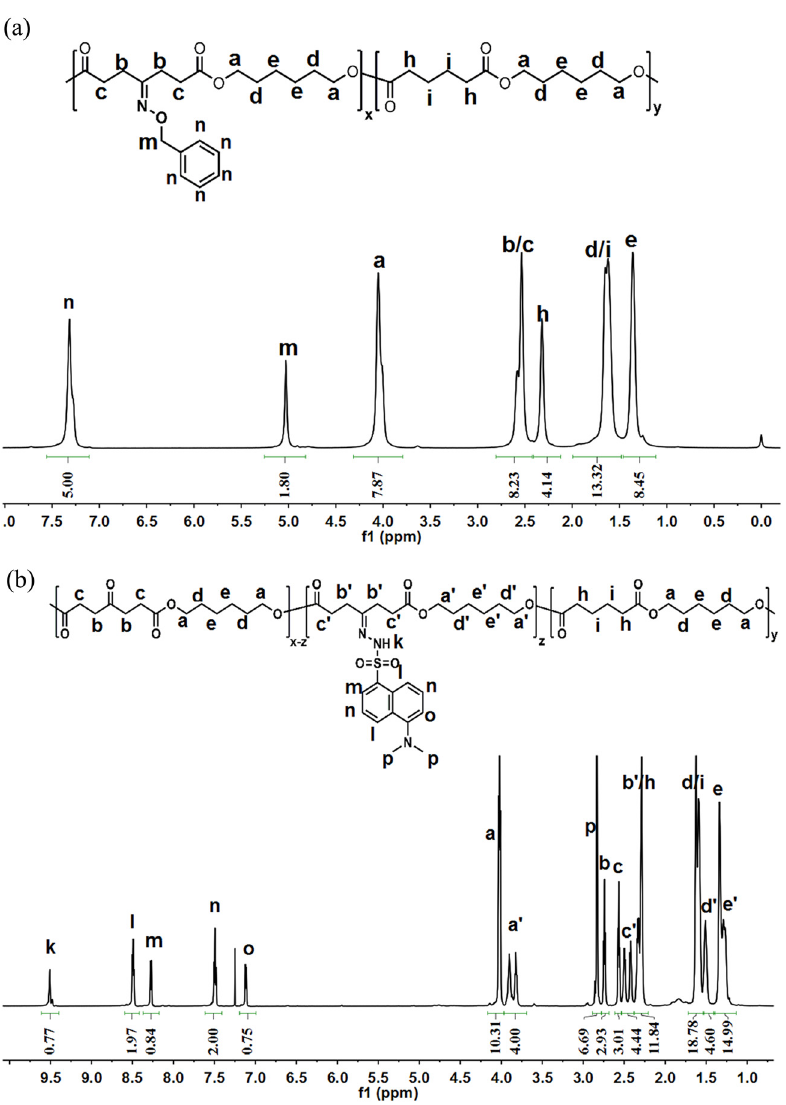
Figure 7: 1 H NMR spectra of P1 ( a ) and P2 ( b ) in CDCl 3